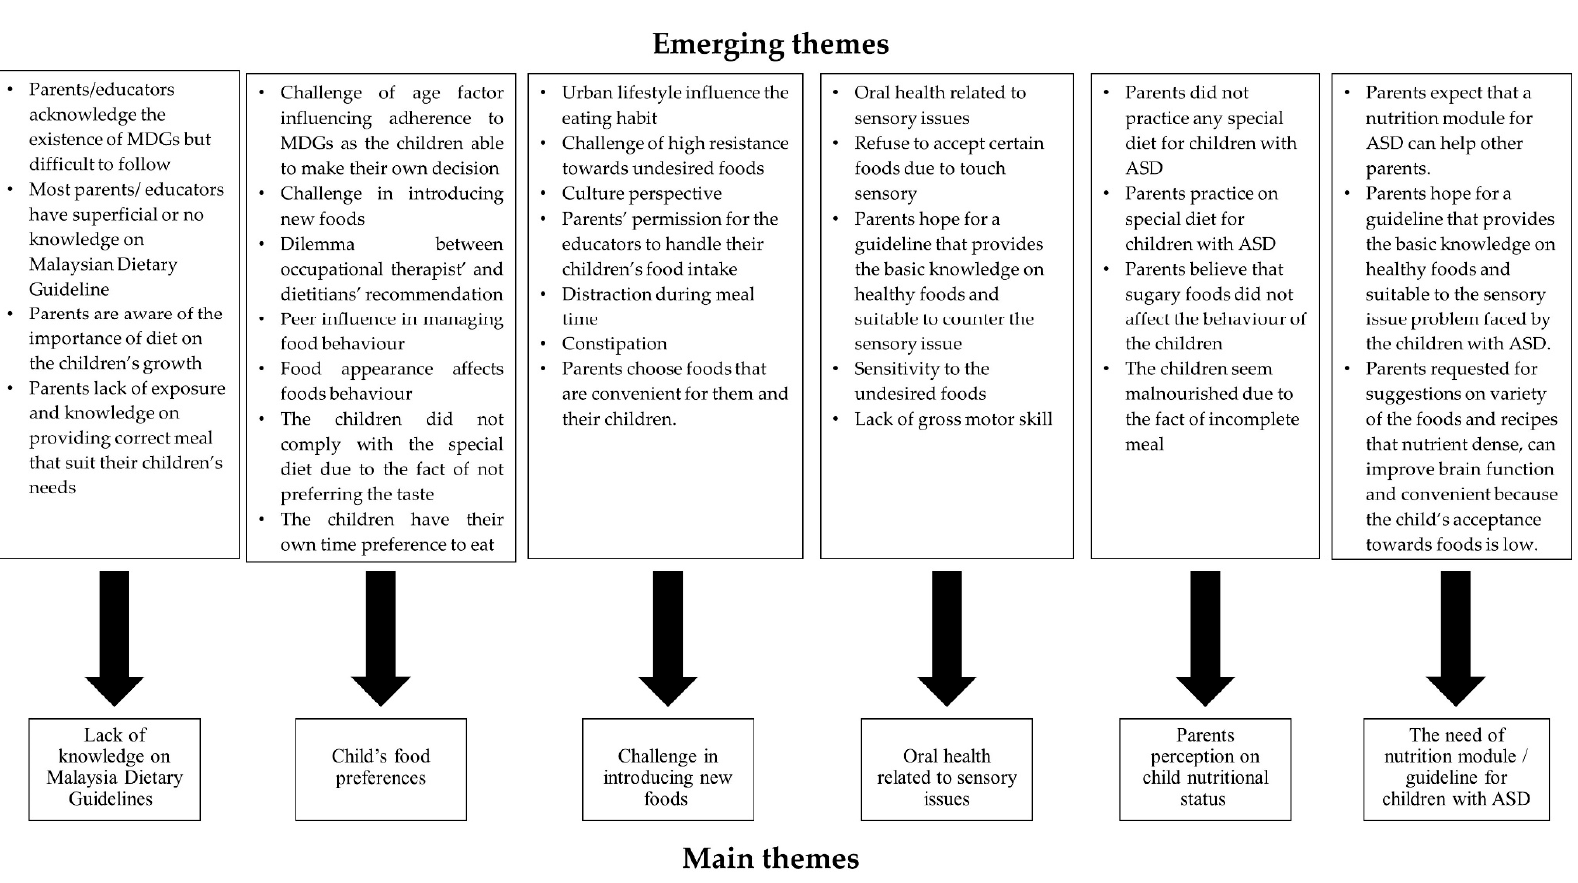
Figure 1. The summary of emerging themes based on the focus group discussions.